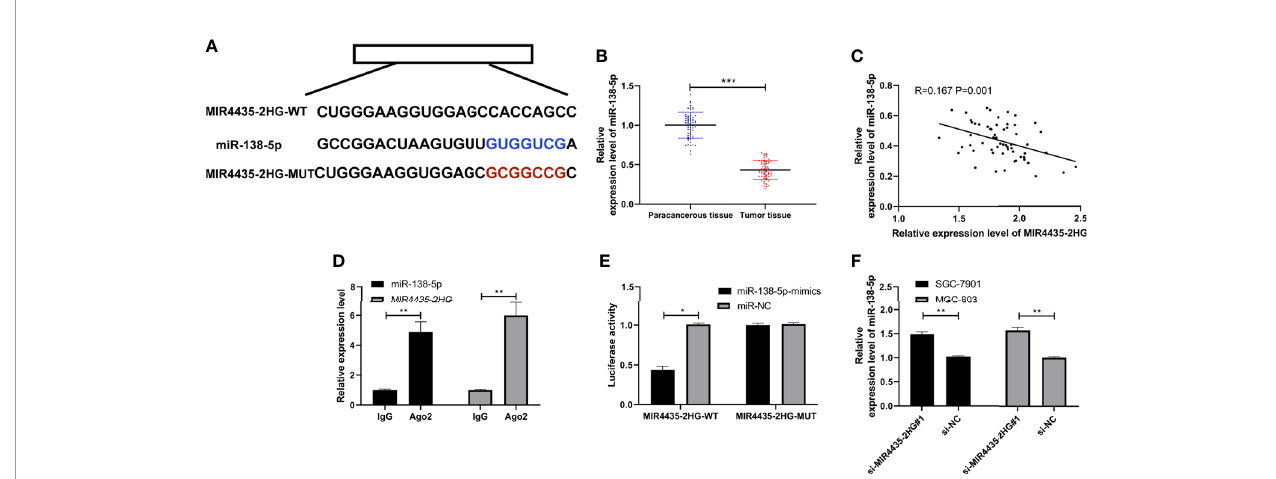
FIGURE 3 | MIR4435-2HG bind to miR-138-5p. (A) Speci fi c binding sites of MIR4435-2HG with miR-138-5p. (B) qRT-PCR detection of miR-138-5p in gastric carcinoma patients. (C) Pearson ’ s test analyzed the correlation of MIR4435-2HG with miR-138-5p in gastric carcinoma patients. (D) RNA immunoprecipitation (RIP) experiment con fi rmed that MIR4435-2HG combined with miR-138-5p in SGC-7901 and MGC-803 cells. (E) Double luciferase report con fi rmed that MIR4435-2HG combined with miR-138-5p in SGC-7901 and MGC-803 cells. (F) MiR-138-5p in gastric carcinoma cells transfected with si-MIR4435-2HG#1 was tested using qRT- PCR in SGC-7901 and MGC-803 cells. * indicates p < 0.05; ** indicates p < 0.01; *** indicates p <